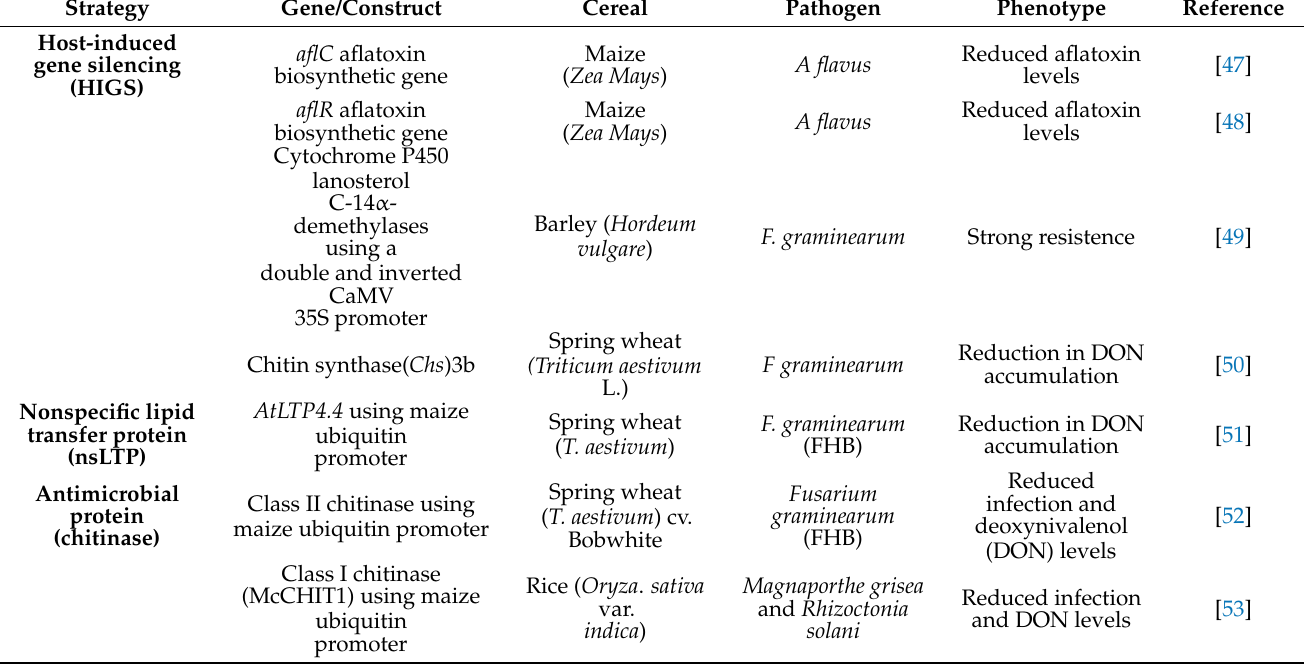
Table 2. Examples of enhanced disease resistance using transgenetic